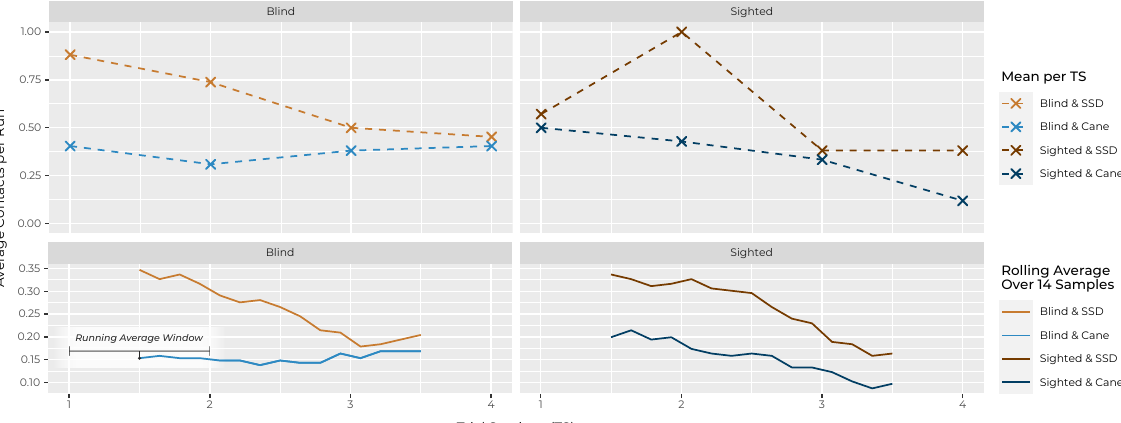
Figure 6. Trial sessions (TS) vs. average number of contacts with obstacles per run. The upper half shows the means per TS; The lower one shows a running average (running over all samples) calculated to better visualise trends. Note the wide window of 14 samples per data point. The plot is split horizontally by group (blind/sighted) and subdivided by aid in colour